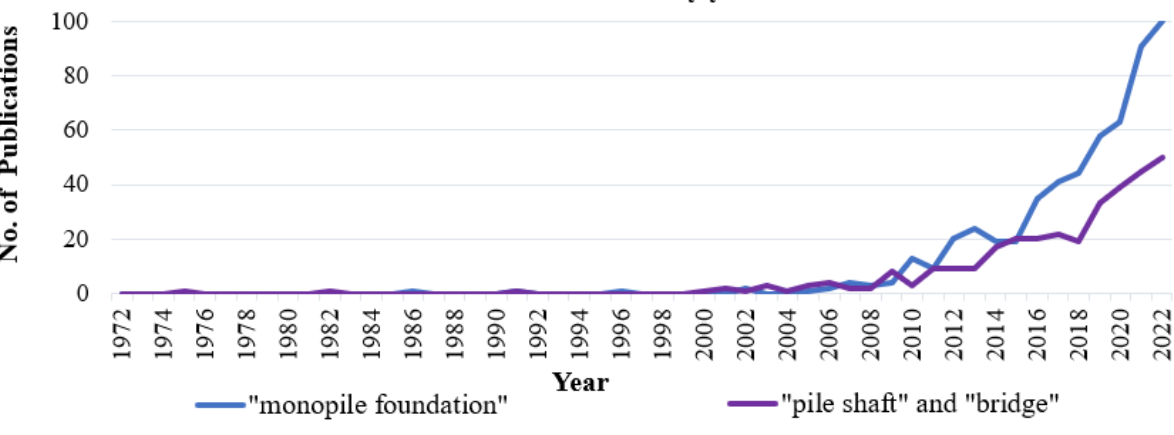
Figure 7 . Graphical presentation of published research by year for monopile foundation.